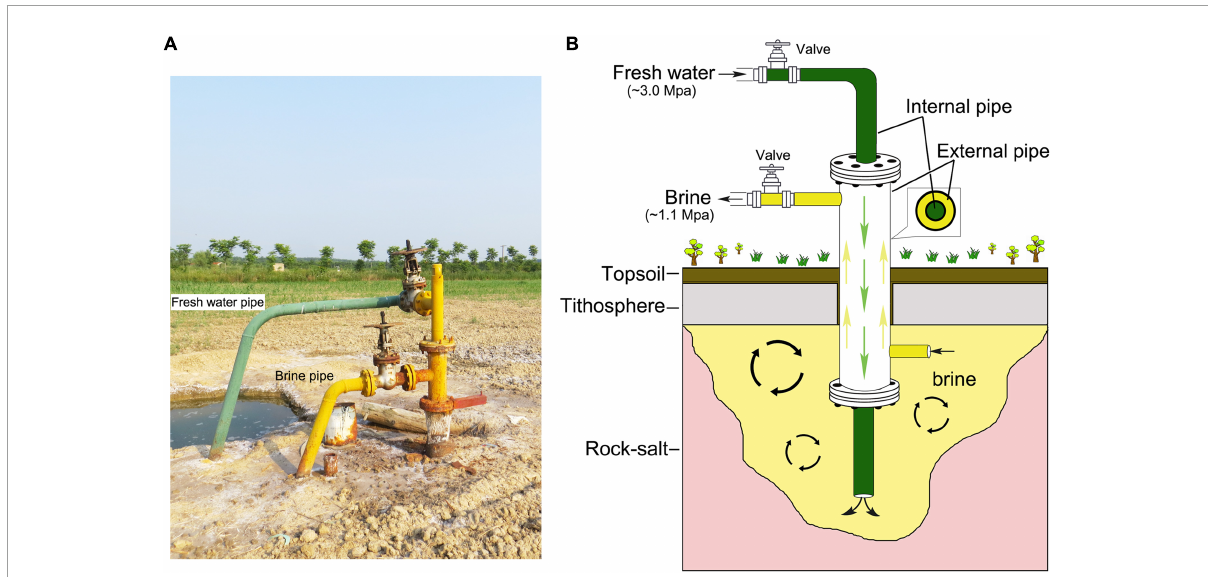
FIGURE1 Landscape of the sampling site and brine production mode. (A) The surrounding landscape of the sampling site. The fresh water (green pipe) with high pressure was pumped into the underground salt mine and the industry brine (yellow pipe) with relative low pressure flowed out. (B) The working principle of rock salt mining is fresh water-in (green, ∼ 3.0 Mpa) and brine-out (yellow, ∼ 1.1 Mpa). Green arrows indicate the direction of fresh water in the internal pipe, and the yellow arrows indicate the direction of industry brine in the external pipe.